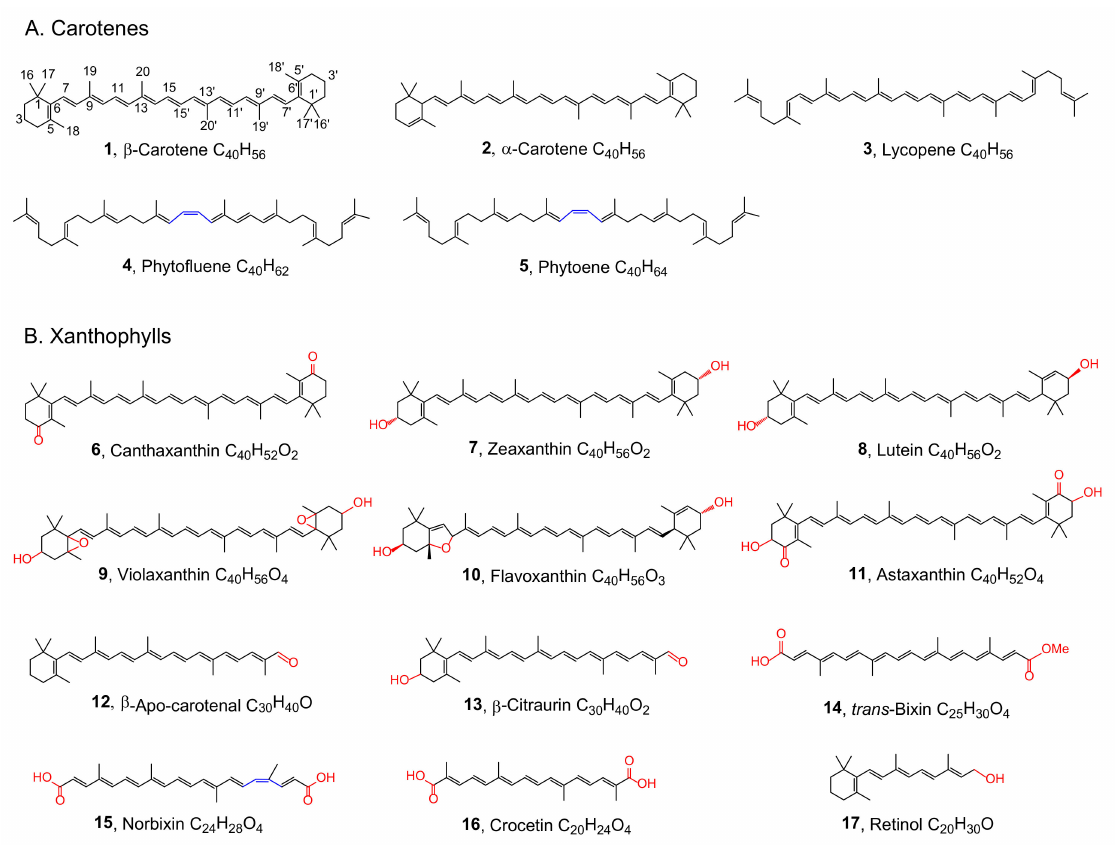
Figure 1. Structures of selected carotenes and